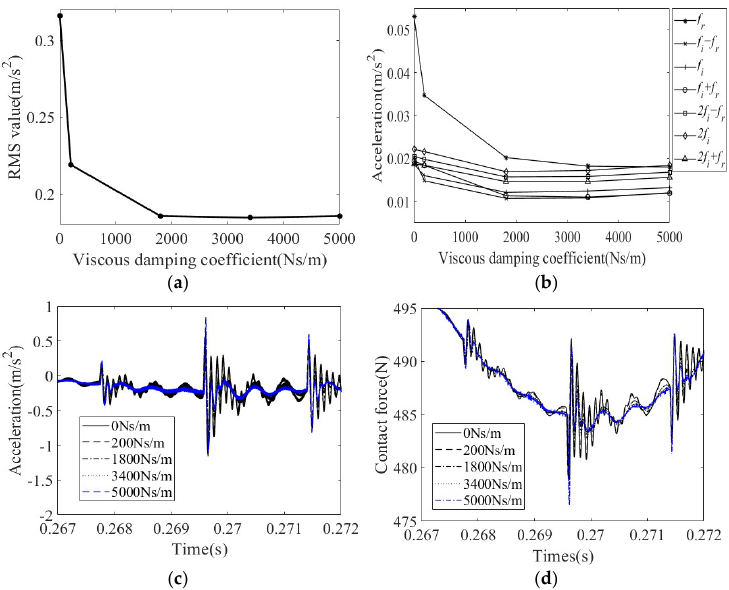
Figure 13. The vibration characteristics of the bearing under inner ring defect and viscous damp- ing: ( a ) RMS; ( b ) amplitudes of f r , f i − f r , f i , f i + f r , 2 f i − f r , 2 f i , 2 f i + f r ; ( c ) housing acceleration signal from 0.267 s to 0.272 s; ( d ) contact force between outer ring and housing from 0.267 s to 0.272 s.